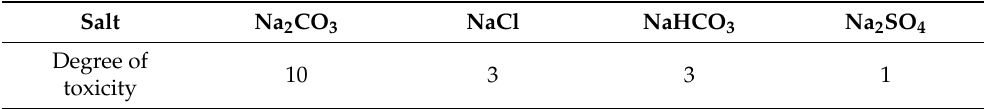
Table 1. Toxicity levels of dominant